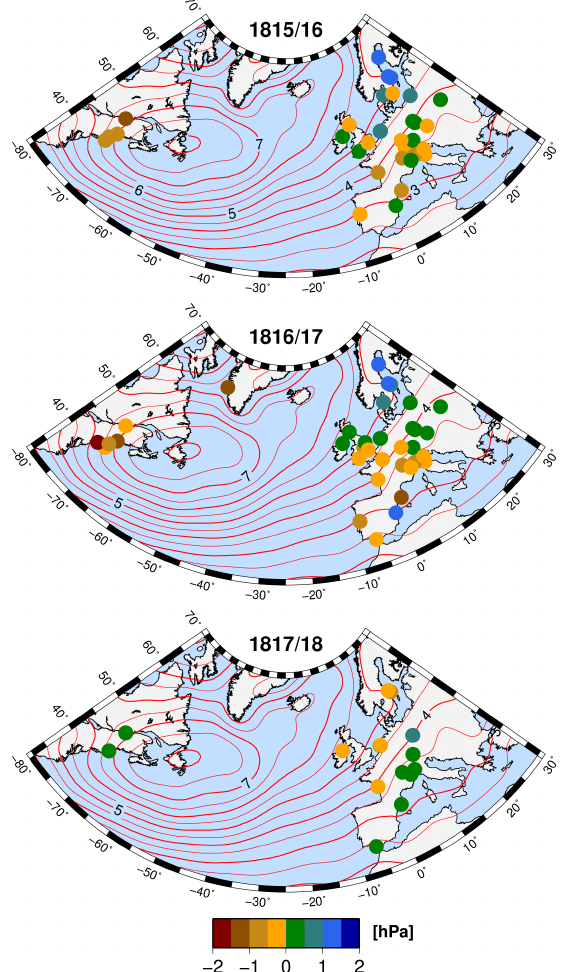
Figure 6. SD of daily (12:00UTC) bandpass-filtered SLP (in hPa) in winter (120-day period starting on 15 November). Contours show the 1961–1990 climatology in the Twentieth Century Reanalysis. Points represent observations for 1815/16, 1816/17 and 1817/18 in terms of anomalies from the nearest grid point in the